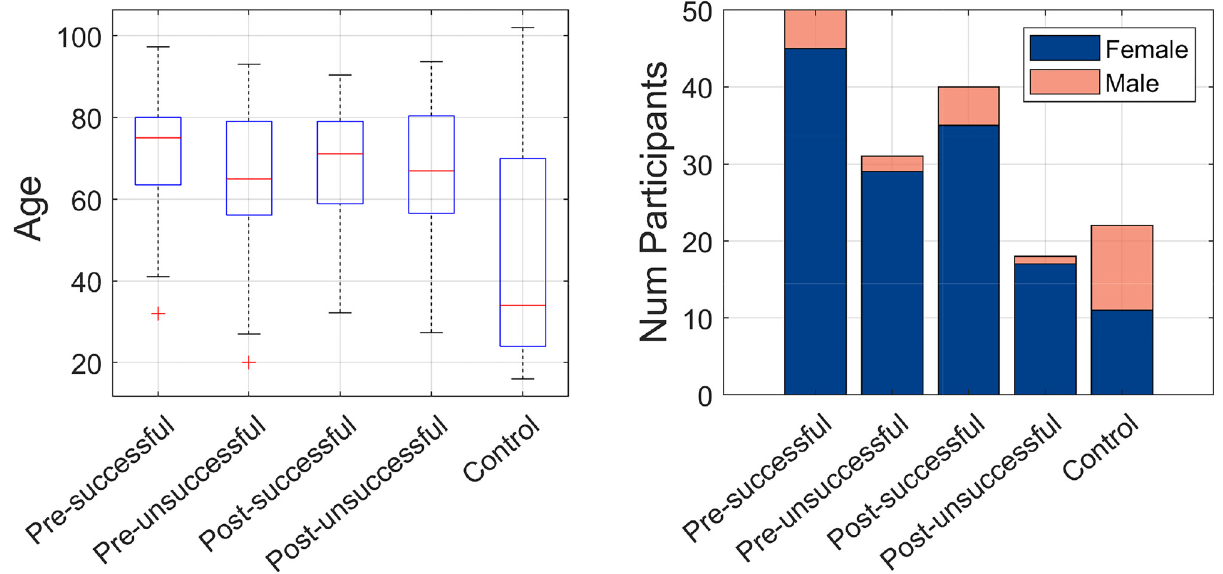
Fig 1. Graphical illustration of the demographic distribution of the population of the study. (a) Age distribution is shown with boxplots, one per group of the study. (b) Female and Male distribution is shown with bars, one per group of the study.